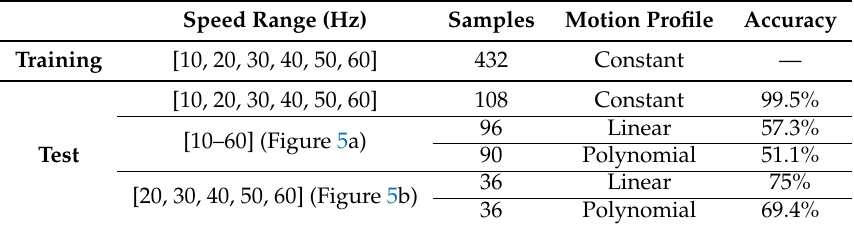
Table 2. Accuracy of the SVM with respect to the motion profile.